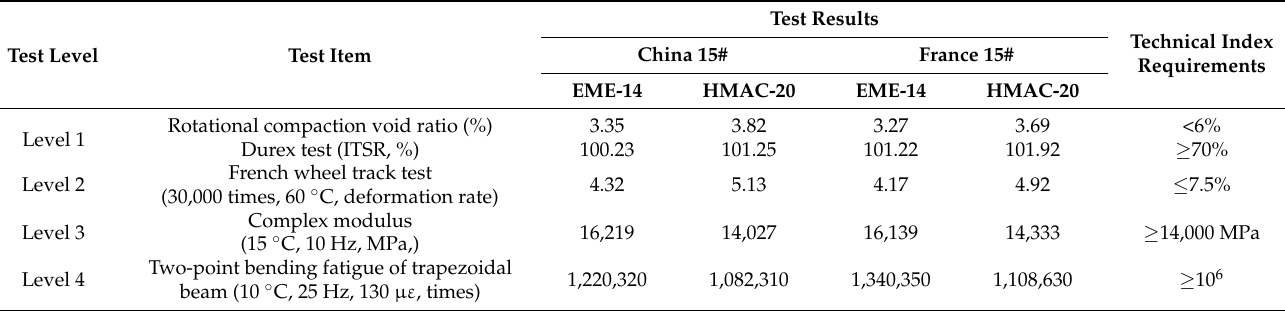
Table 8. Performance test results of level 1 to level